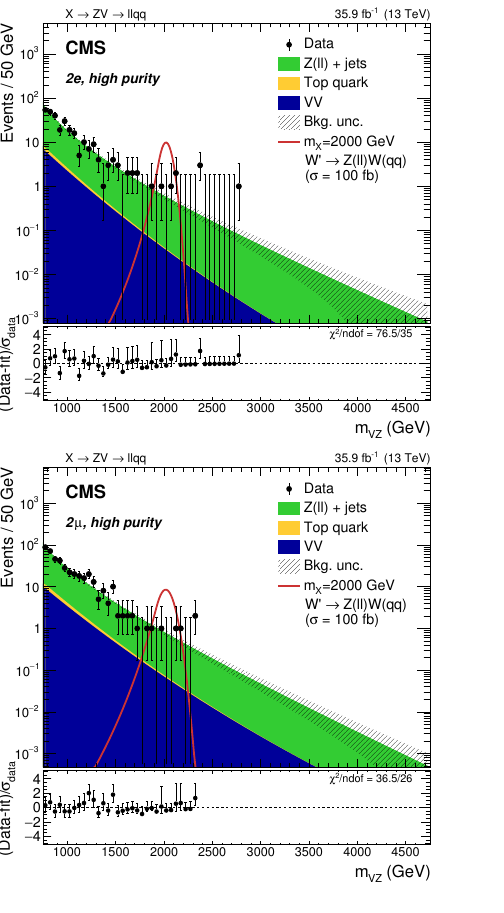
Figure 3 . Expected and observed distributions of the resonance candidate mass m VZ in the high- mass analysis, in the electron (upper) and muon (lower) channels, and separately for the high-purity (left) and low-purity (right) categories. The shaded area represents the post-(cid:12)t uncertainty in the background. The bottom panels show the pull distribution between data and post-(cid:12)t SM back- ground (cid:12)t, where (cid:27) data is the Poisson uncertainty in the data. The expected contribution from W 0 signal candidates with mass m X = 2000 GeV, normalized to a cross section of 100 fb, is also